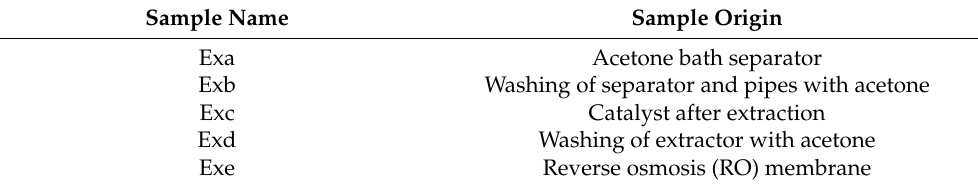
Figure 10. Scheme of the extraction apparatus for detailed investigations. Table 7. Sample nomenclature for the detailed